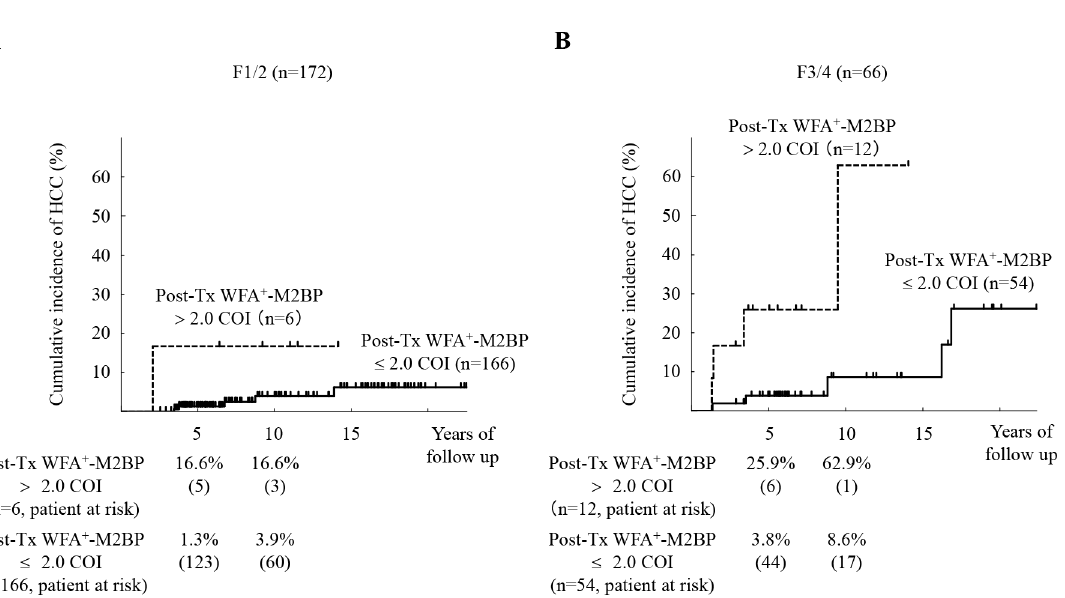
Fig 3. Cumulative incidence of hepatocellular carcinoma (HCC) according to post-treatment WFA + -M2BP values, stratified by stage of fibrosis. (A): F1/2 (n = 172). (B): F3/4 (n = 66). Cumulative incidences of HCC according to post-treatment WFA + -M2BP values were analyzed using the Kaplan-Meier method. The black solid and dotted lines indicate the stratified post-treatment WFA + -M2BP values with a COI (cid:5) 2.0 and a COI > 2.0, respectively. There were no significant differences in HCC incidence with F1/2 group ( P = 0.09 by the log-rank test). On the other hand, the incidence rate differed significantly with F3/ 4 group ( P < 0.01 by the log-rank test). The numbers of patients at risk at each time point are shown below the graphs.